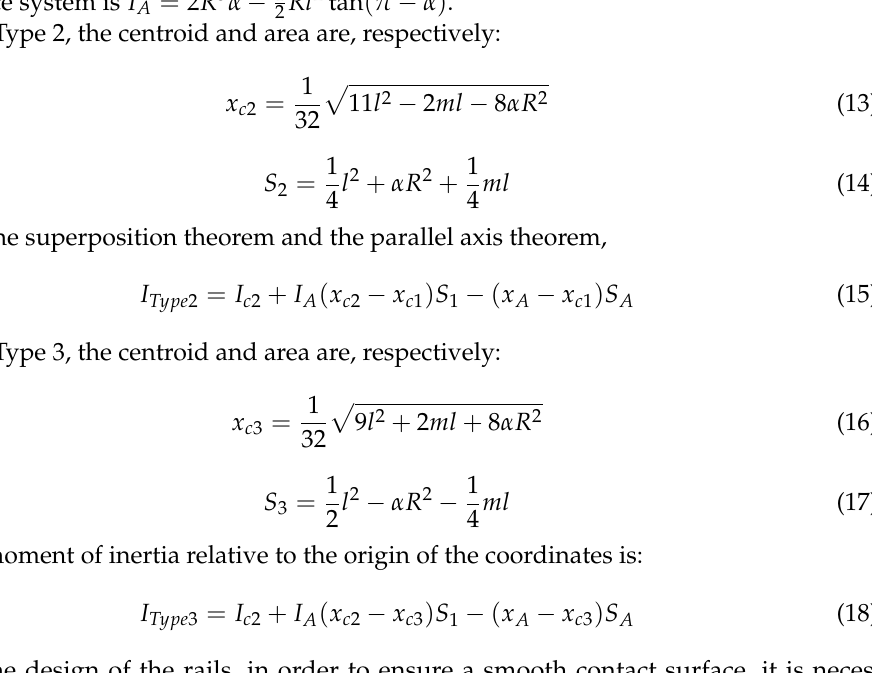
MN always tangent to PM and QN . Therefore, the relationship shown in Equation (18) can be obtained.